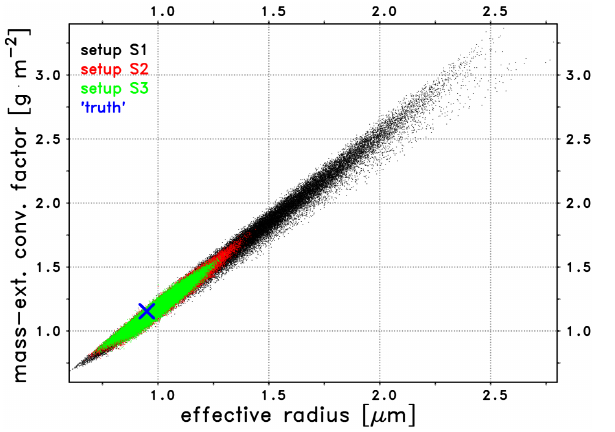
Figure 4. Probability distributions of solution ensembles for setups S1 (black), S2 (red), and S3 (green) with effective radius r eff in bins of 0.1µm width; r eff of the input ensemble (“truth”) is shown as a vertical